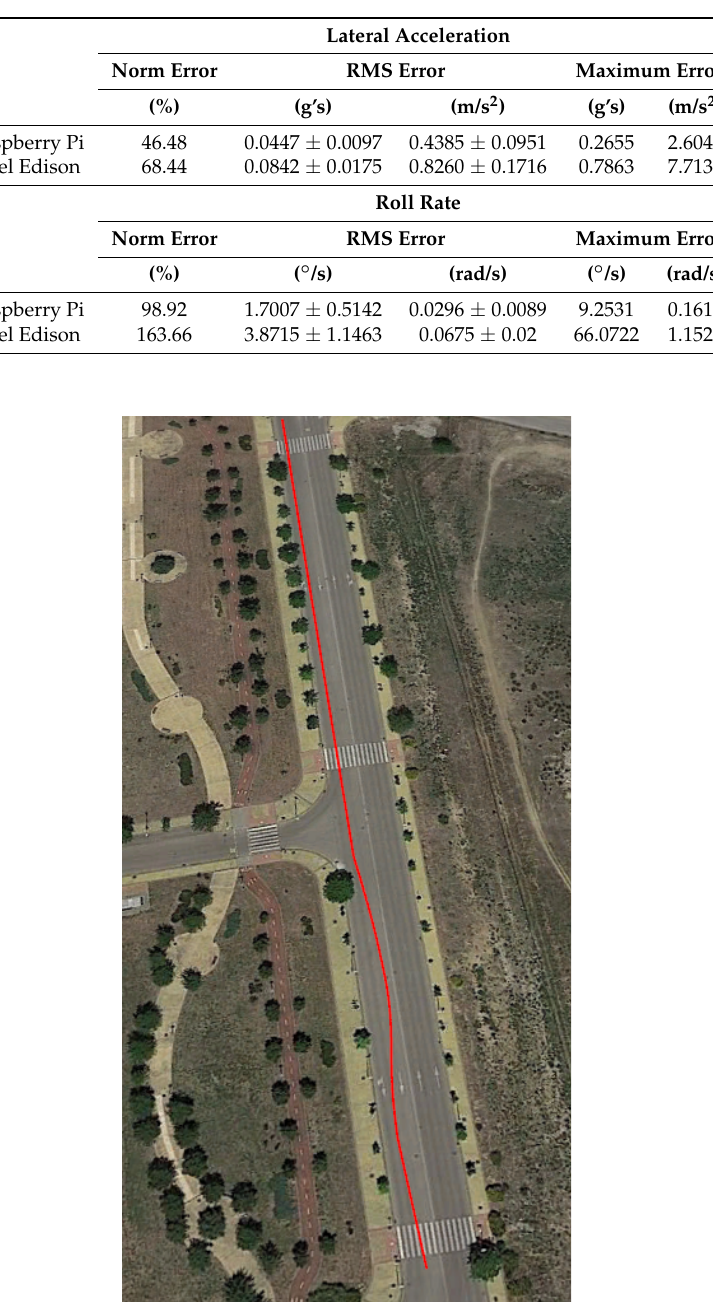
Table 8. Test 2: Errors of lateral acceleration and roll rate data for the accelerometers and gyroscopes mounted on Raspberry Pi and Intel Edison compared with the IMU from VBOX (ground truth).